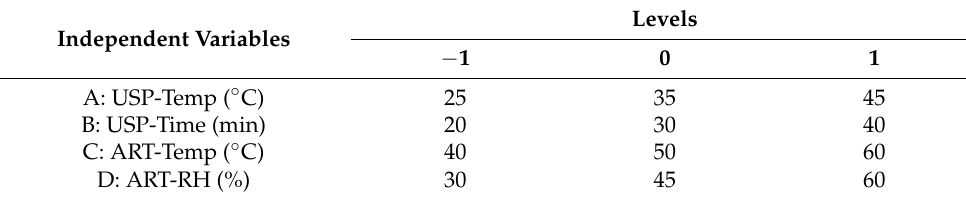
Table 1. The levels and values of the independent variables applied in the response surface design for the